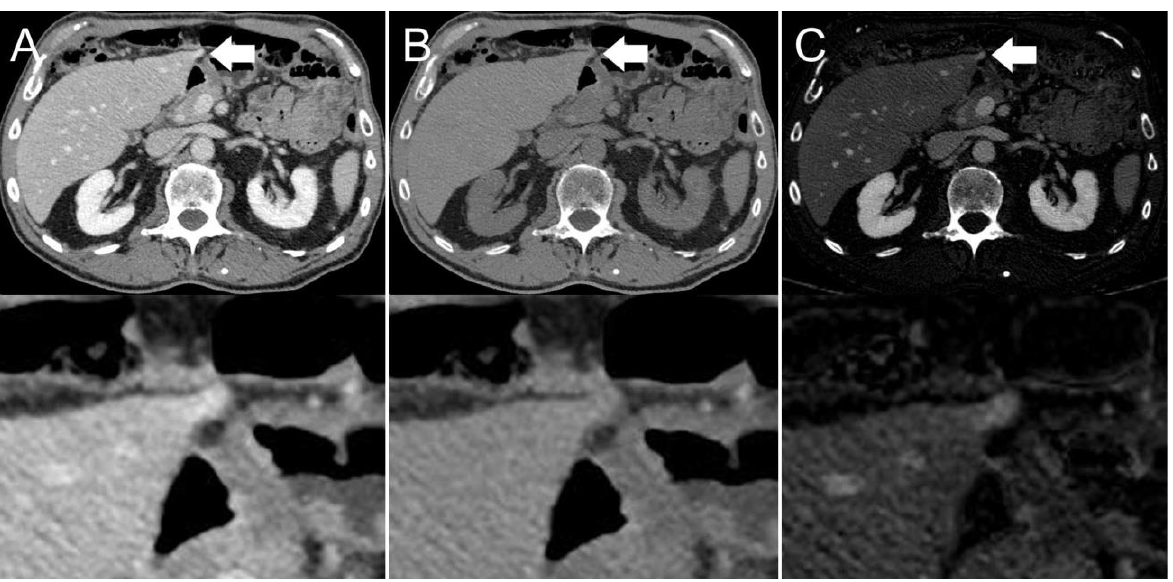
Figure 4. Axial contrast-enhanced CT scan of an 86-year-old man. Hyperdensity (indicated by arrows) on the left liver lobe in the ( A ) conventional 120 kVp image, which might be interpreted as a peristalsis-related streak artifact originating from the stomach. The ( B ) virtual non-contrast (VNC) image reconstruction and ( C ) iodine image reconstruction reveal that it is not a streak artifact, but a hyperenhancing liver lesion.